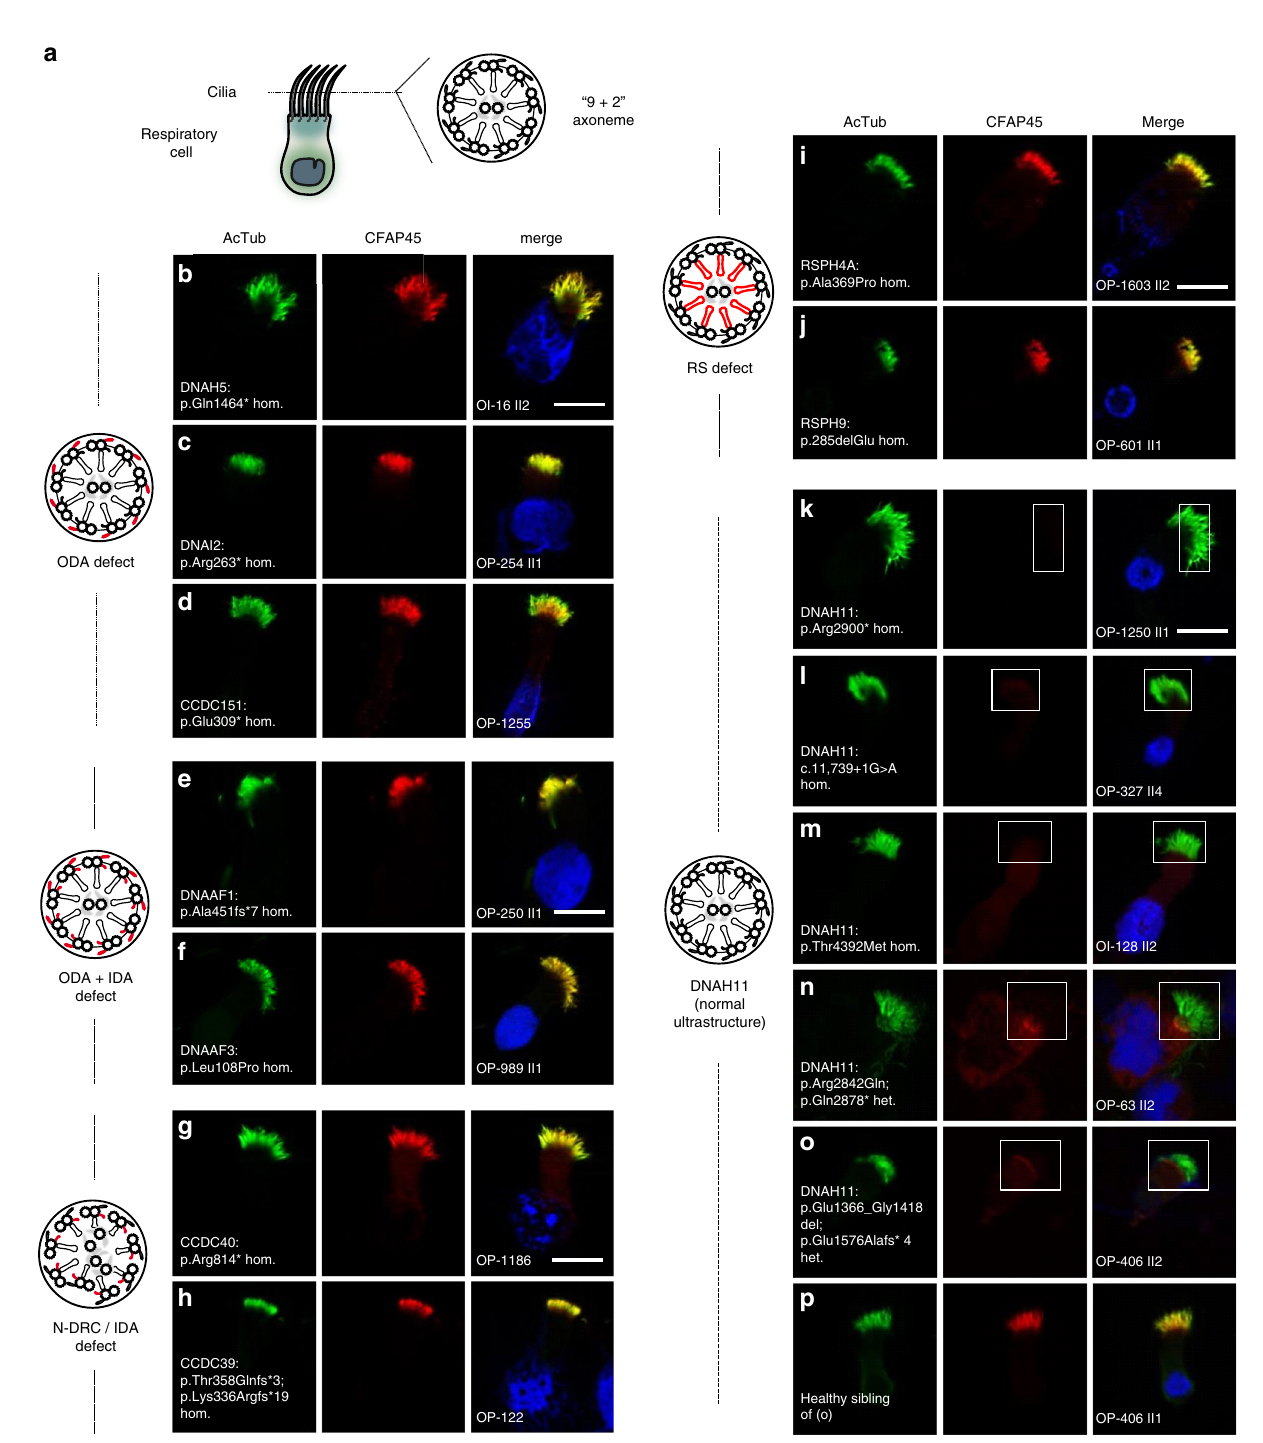
CCDC39: p.Thr358Glnfs*3; p.Lys336Argfs*19 hom.